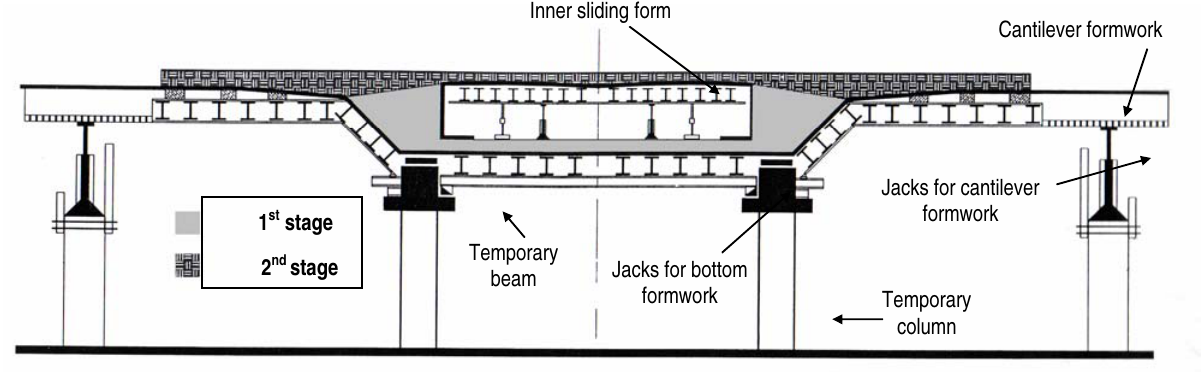
Fig 2 . Components of deck form